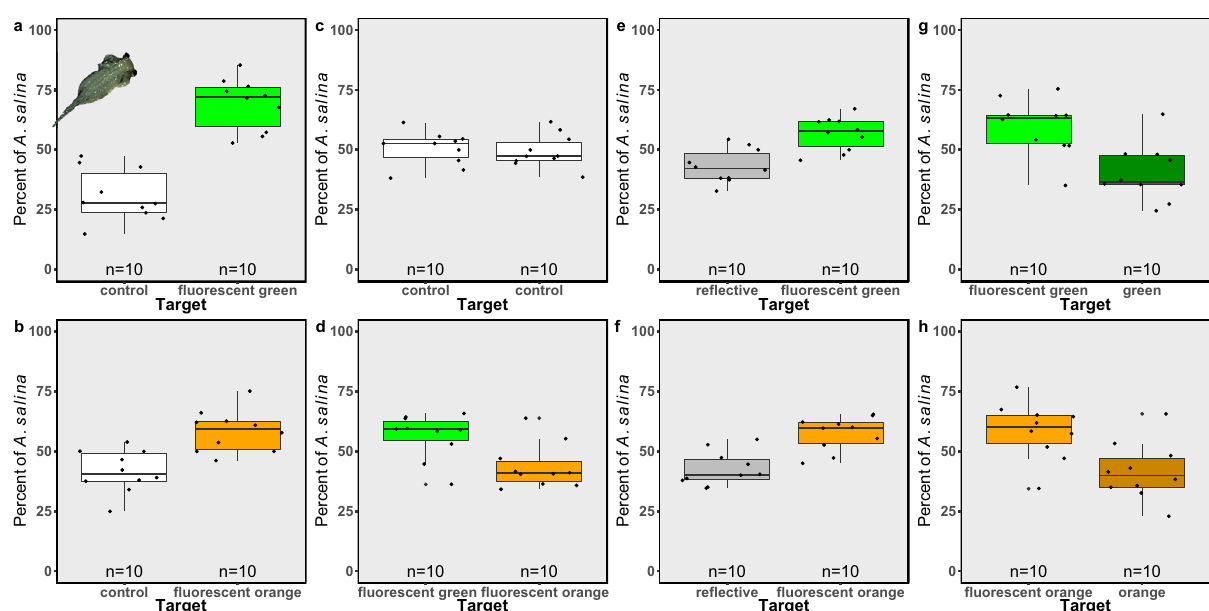
Fig. 1 The attraction of Artemia salina to fl uorescent and non- fl uorescent targets. Attraction to fl uorescent ( fl uorescent green or fl uorescent orange) or non- fl uorescent (control, re fl ective, green, and orange) targets presented as the percentage of A. salina attracted to each target. a Clear target ( “ control ” ; white boxes) versus fl uorescent green target (bright green boxes), b control target versus fl uorescent orange target (bright orange boxes), c control target versus control target, d fl uorescent green target versus fl uorescent orange target, e fl uorescent green target versus re fl ective target (gray boxes), f fl uorescent orange target versus re fl ective target, g fl uorescent green target versus non- fl uorescent green target (dark green boxes), and h fl uorescent orange target versus non- fl uorescent orange target (dark orange boxes). n = 10 trials for each combination. Boxes represent the upper and lower quartile, centerlines represent medians, and whiskers extend to data measurements that are less than 1.5*IQR away from the fi rst/third GLMM, p = 0.89, Cohen ’ s d = 0.04). The fi sh also did not show a preference when given a fl uorescent green and non- fl uorescent green target or between a fl uorescent orange and non- fl uorescent orange target (Fig. 3e, f; GLMM, p = 0.68, Cohen ’ s d = − 0.27 and p = 0.29, Cohen ’ s d = − 1.59 for green and orange, respectively).